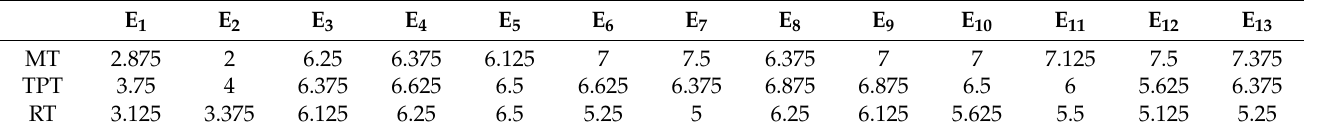
Table 6. Original decision matrix of alternatives.